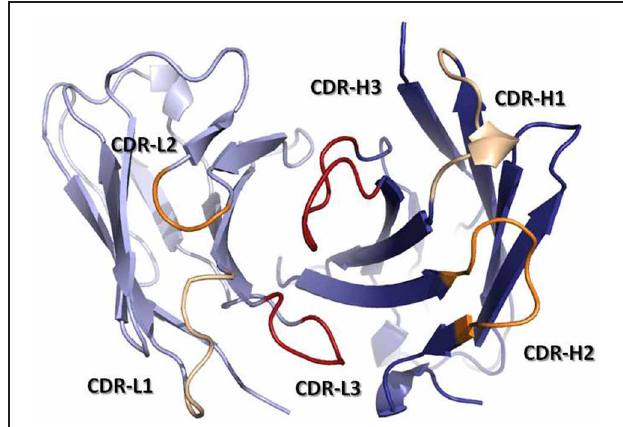
FIGURE 3 | Ribbon representation of a Fv fragment seen from the antigen perspective. V H is colored in dark blue, while V L is colored in light blue. CDRs are colored in yellow (CDR-1), orange (CDR-2), and red (CDR-3). The coordinates used to produce the Figure are the same as in Figure 1 . The Figure was generated with